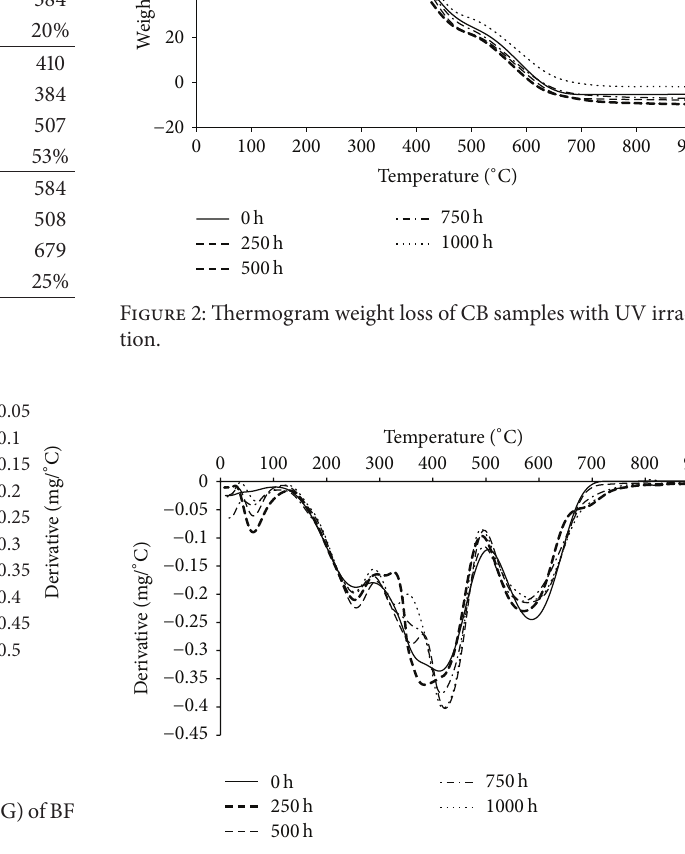
Figure 3: Thermogram DTG of CB samples with UV